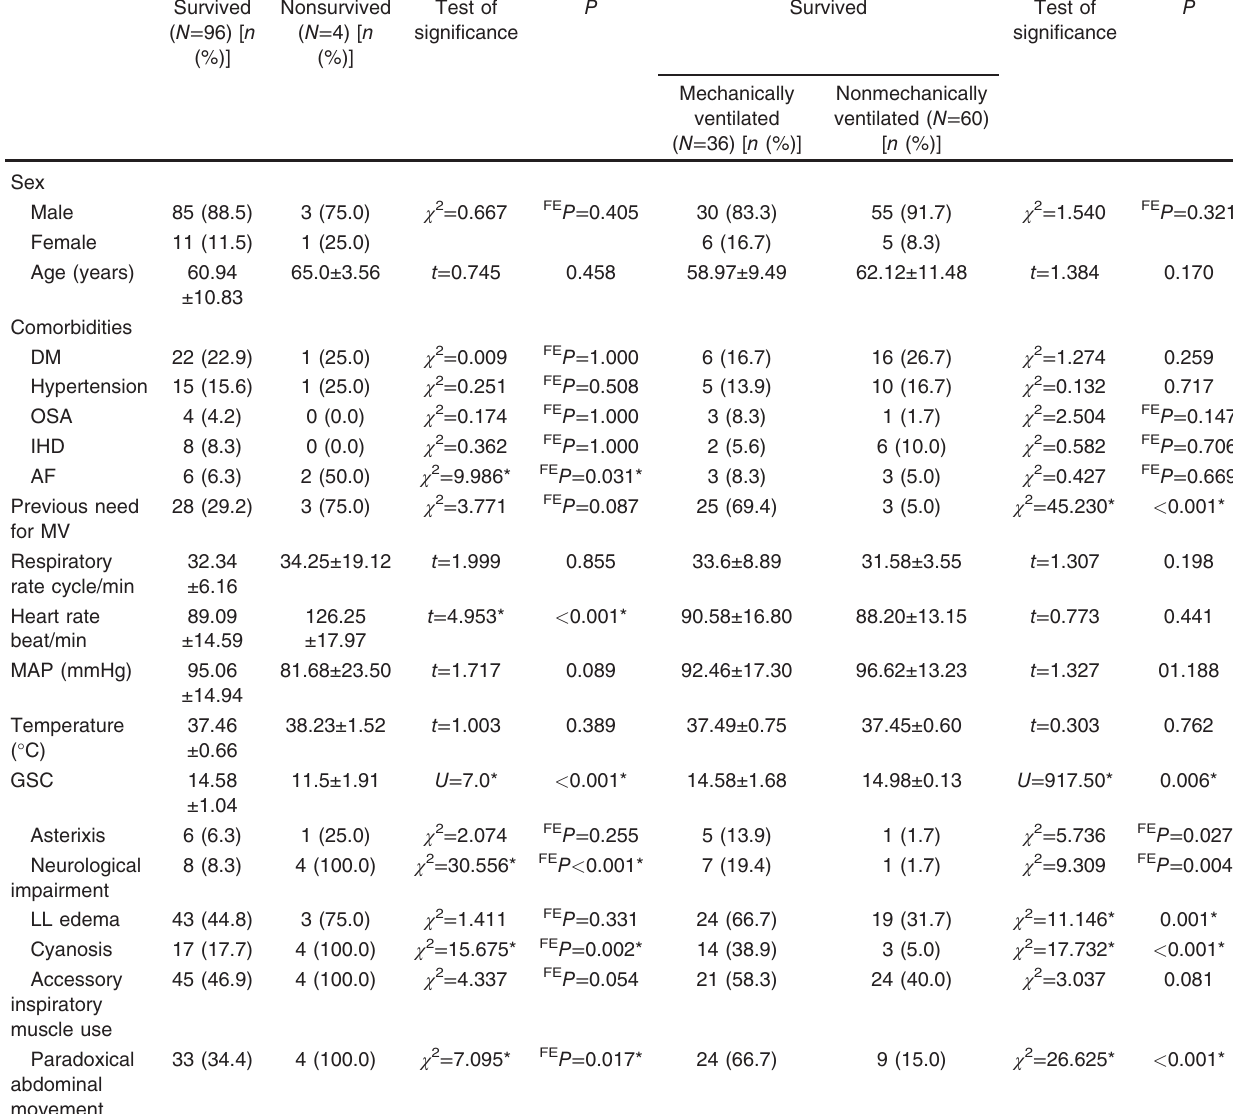
Table 2 Comparison between the different groups according to clinical data Survived ( N = 96) [